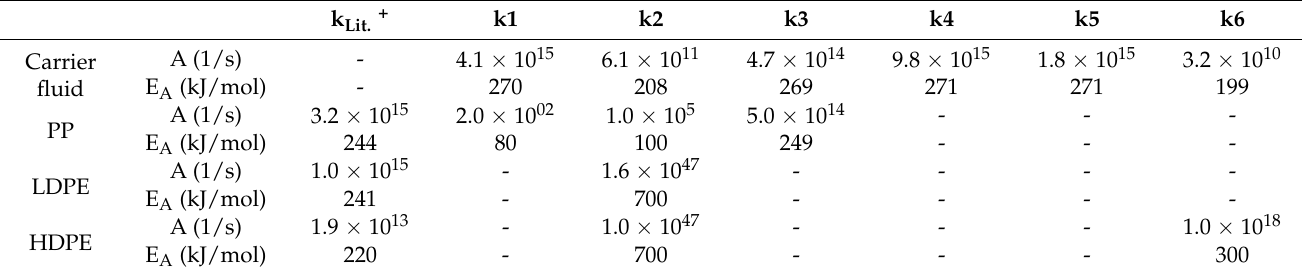
Table 3. Determined Arrhenius constants “A” and Activation Energies” E A ” of the plastic pyrolysis in the pilot plant.